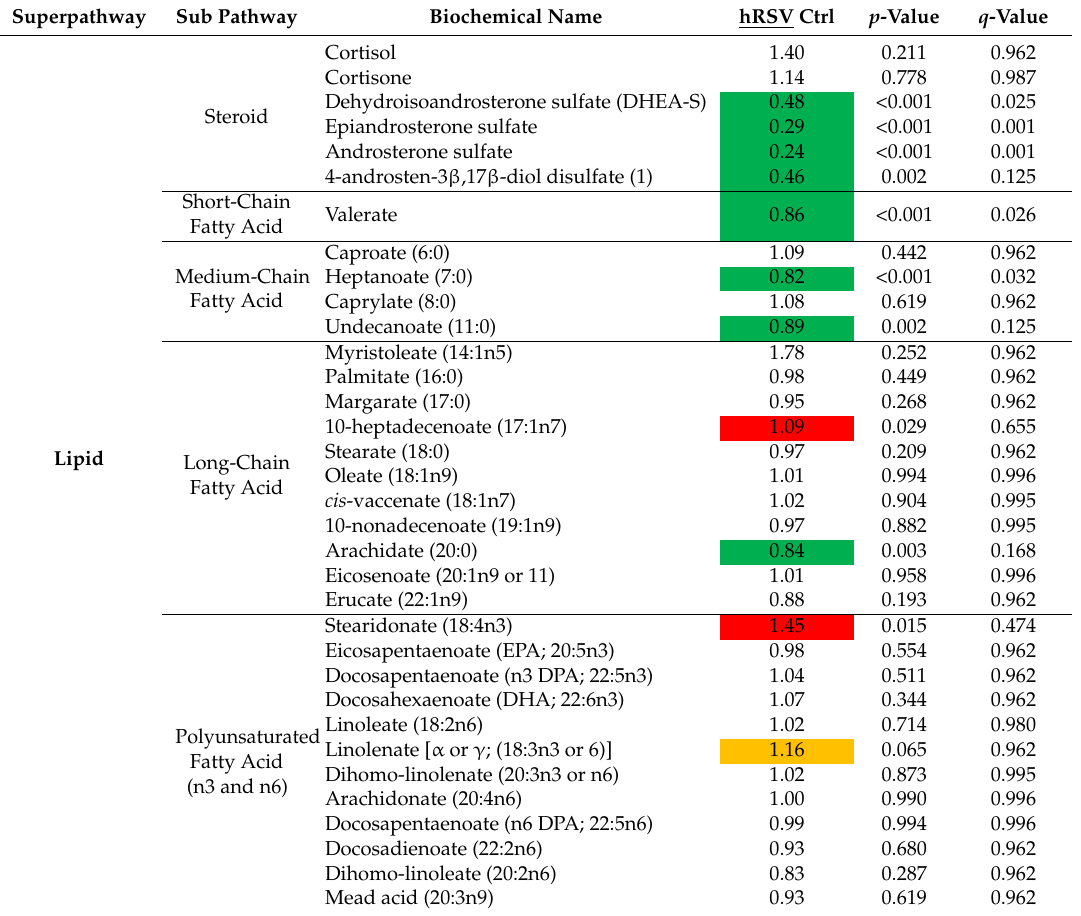
Table 4. Summary of resveratrol-induced changes in skeletal muscle tissue. Identified metabolites in the steroid, short-chain fatty acid, medium-chain fatty acid, long-chain fatty acid, and polyunsaturated fatty acid (n3 and n6) pathways in skeletal muscle. Red: Significant elevation ( p ≤ 0.05). Orange: Trending elevation ( p < 0.10); Green: Significant reduction ( p ≤